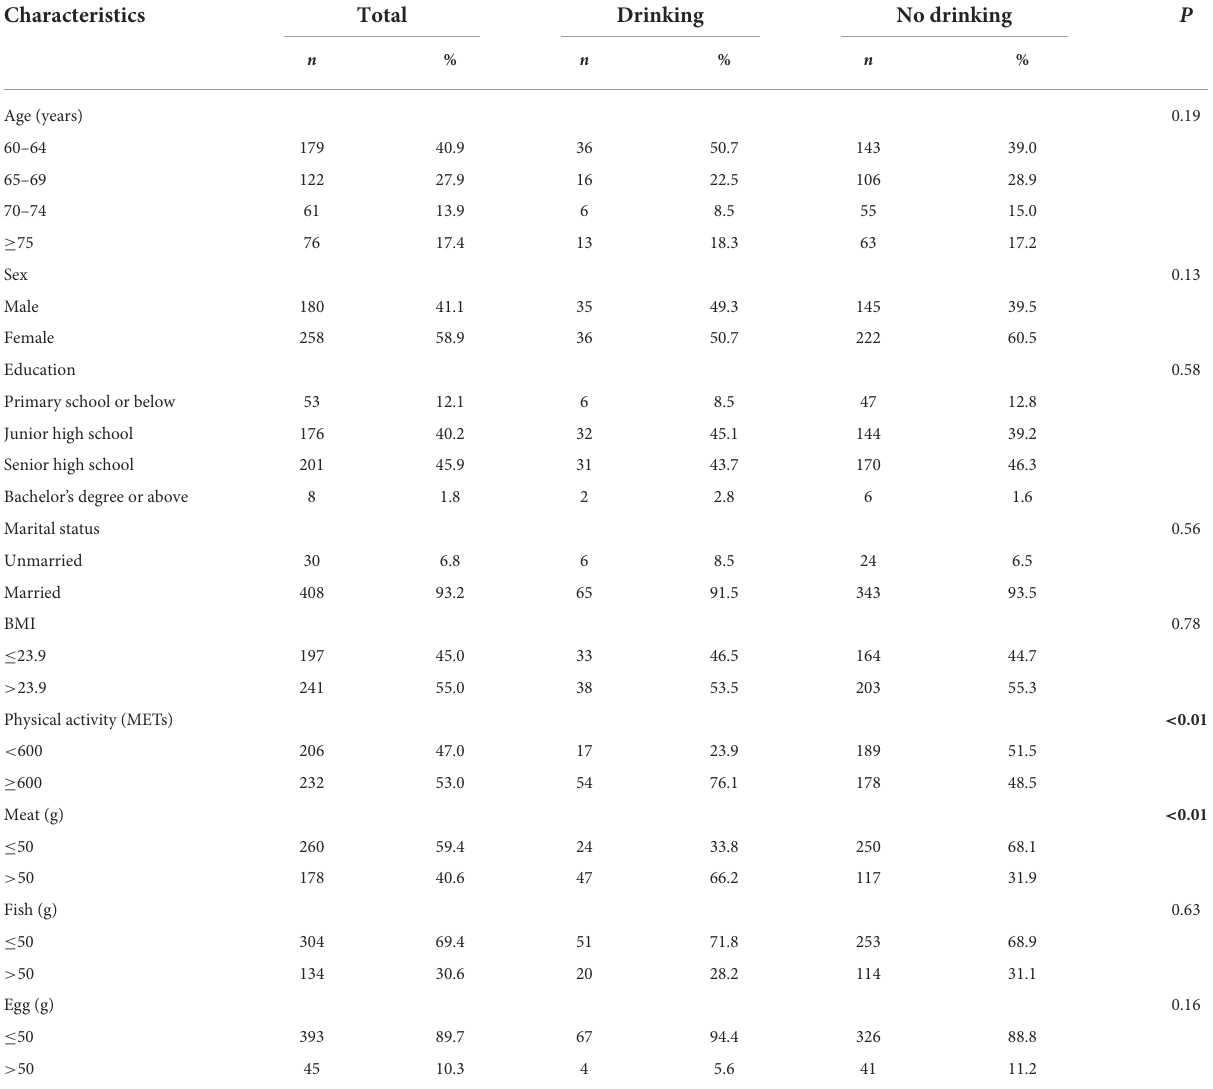
TABLE 1 Sociodemographic information, BMI, PA and diet of the sample according to drinking status. Characteristics